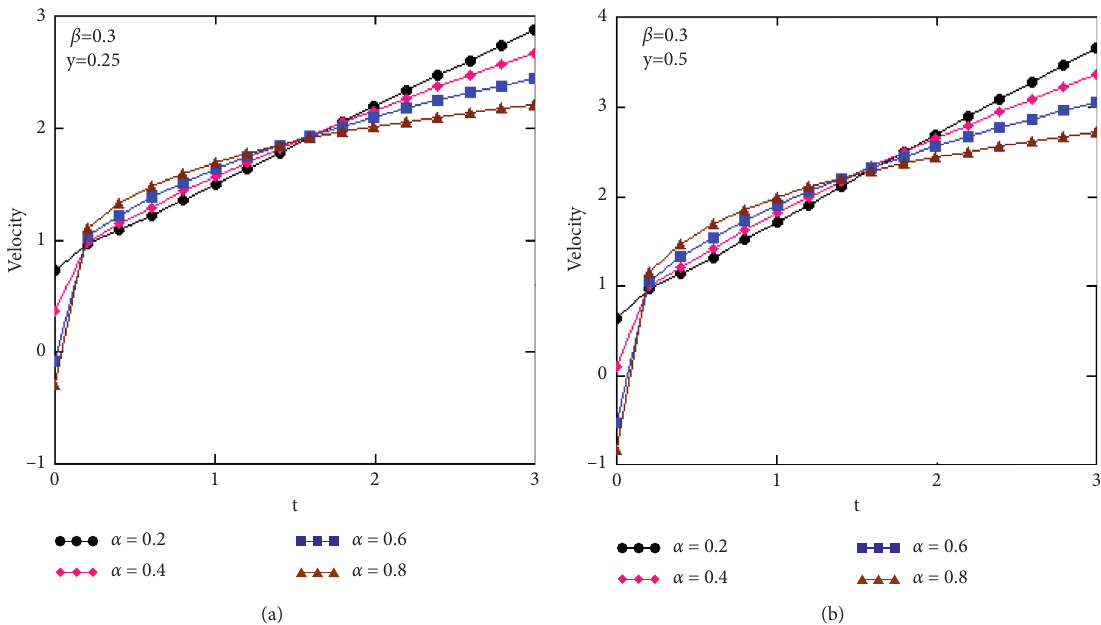
Figure 10: Profiles of dimensionless velocity versus y for variation of α at altered values of time t , Gr � 5 , λ � 2 , λ f